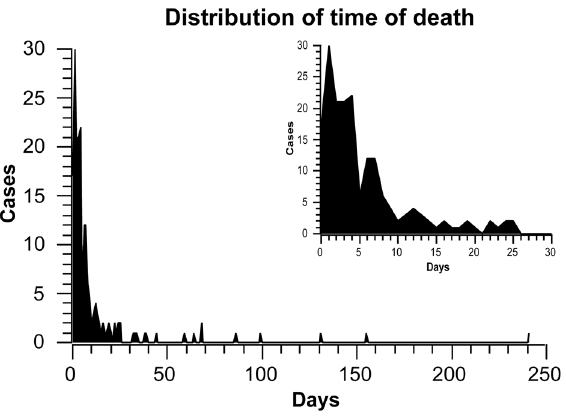
Figure 1. Distribution of time to death in patients with basal ganglia hemorrhage. The upper right corner shows deaths within 30 days of study